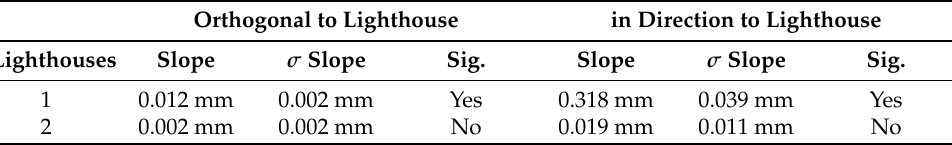
Table 3. Numerical values of precision investigation with regard to the lighthouse and significance (Sig.) at a confidence level of 95%. Orthogonal to Lighthouse in Direction to Lighthouse Lighthouses Slope σ Slope Sig. Slope σ